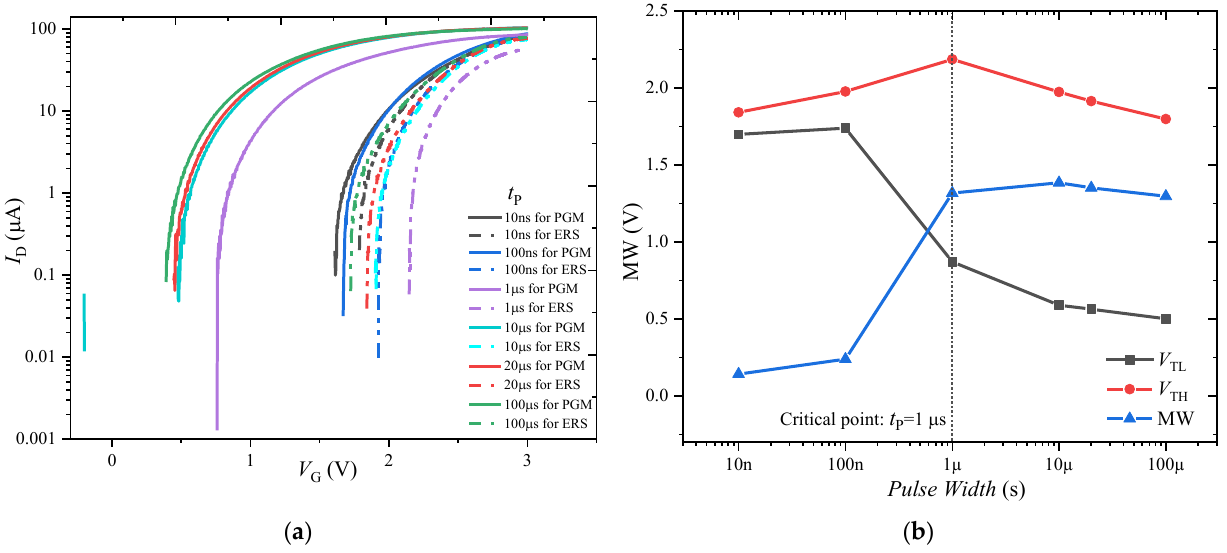
Figure 6. ( a ) I D - V G characteristics of FeFET for varying PGM and ERS pulse widths. ( b ) Variation of V TL , V TH , and MW with respect to various values of pulse width in